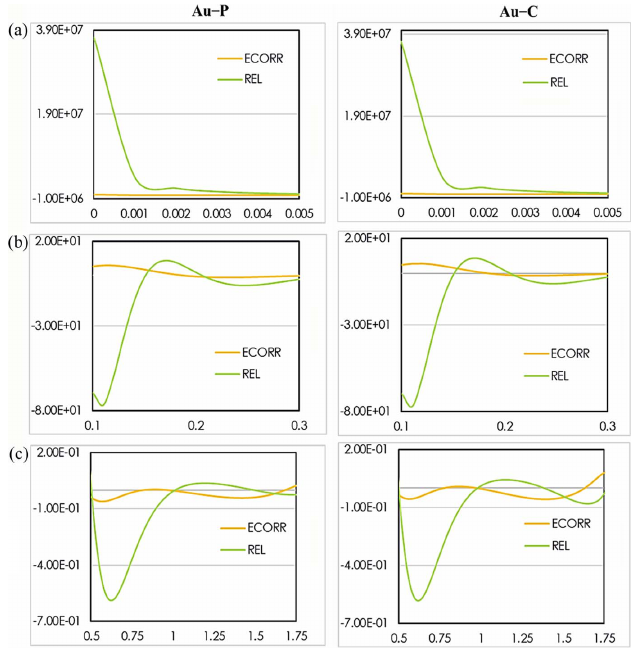
Figure 7 1D difference static electron density plots resulting from the relativistic and electron correlation effects ( y axis, in eA˚ (cid:2) 3 ) as a function of the Au— P and Au—C bond distance ( x axis, in A˚ ) of performed HARs against SP8